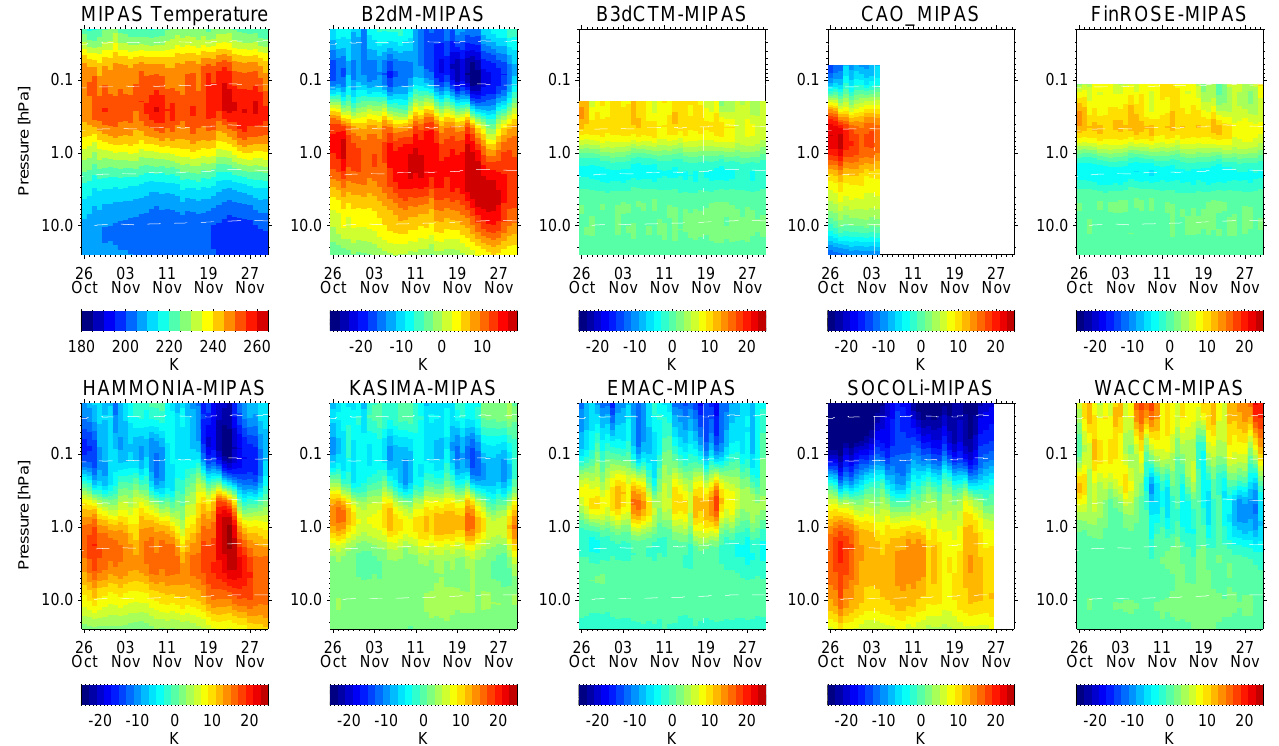
Fig. 8. Temporal evolution of MIPAS temperature and model - MIPAS differences averaged over 70–90 ◦ N. Atmos. Chem. Phys., 11, 9089–9139, or NO + O ). On the other hand, meridional trans- N + O 2 2 3 port and mixing, depending largely on the development stage of the early winter polar vortex, control the redistribution of air masses between polar night and illuminated regions and hence, the efficiency of photochemical losses. Also, the strength of polar winter descent plays an important role in the vertical redistribution of some species on the time scale of the intercomparison period. Figure 7 shows the MIPAS temperature zonal mean dis- tribution at 40–90 ◦ N averaged over the period of the main proton forcing, 29 October to 4 November 2003, and the corresponding differences between the models and the ob-